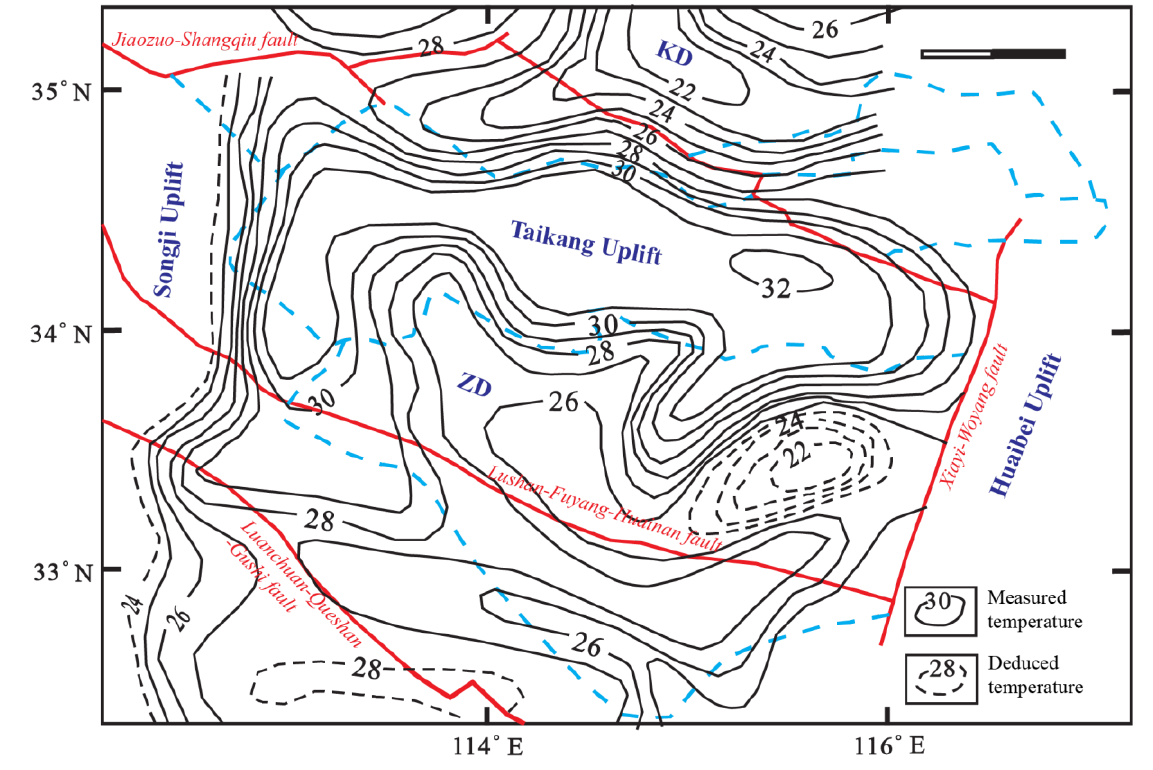
Figure 9. The underground temperature contour of the Taikang Uplift and adjacent areas at a depth of 300 m, after [28]. KD: Kaifeng Depression, and ZD: Zhoukou